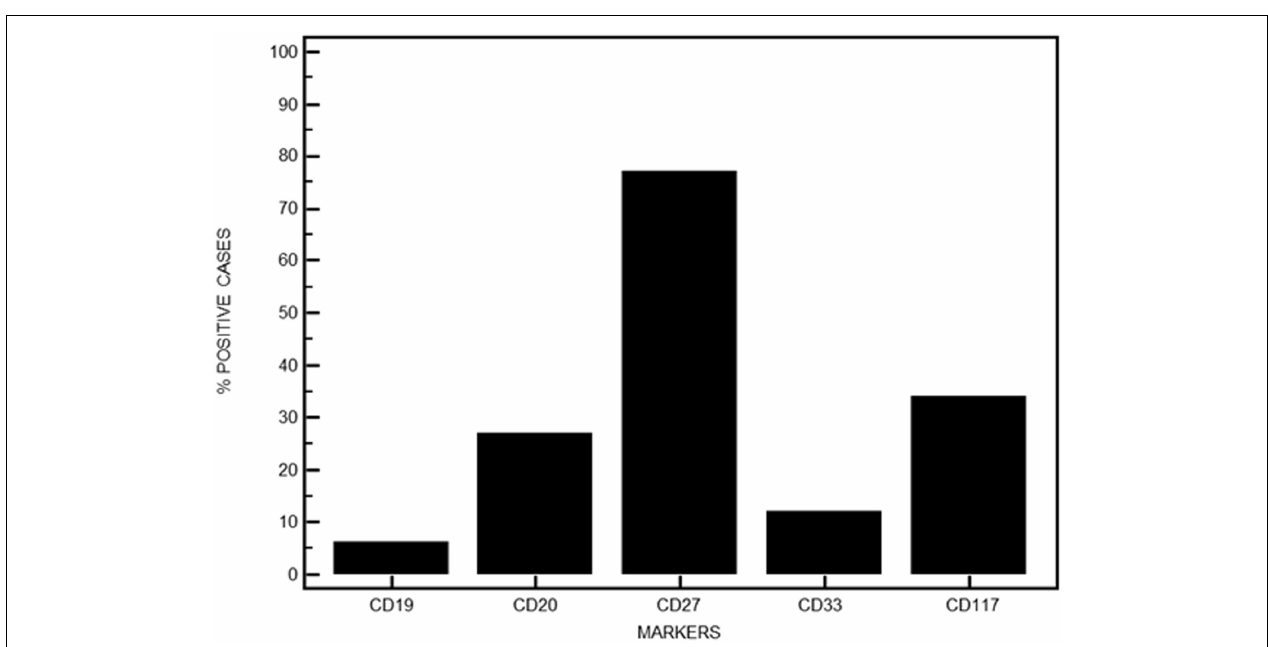
FIGURE 5 | Immunophenotypic features of MM PC when investigating other aberrant surface markers . Data are expressed in percentages for the series presented here.